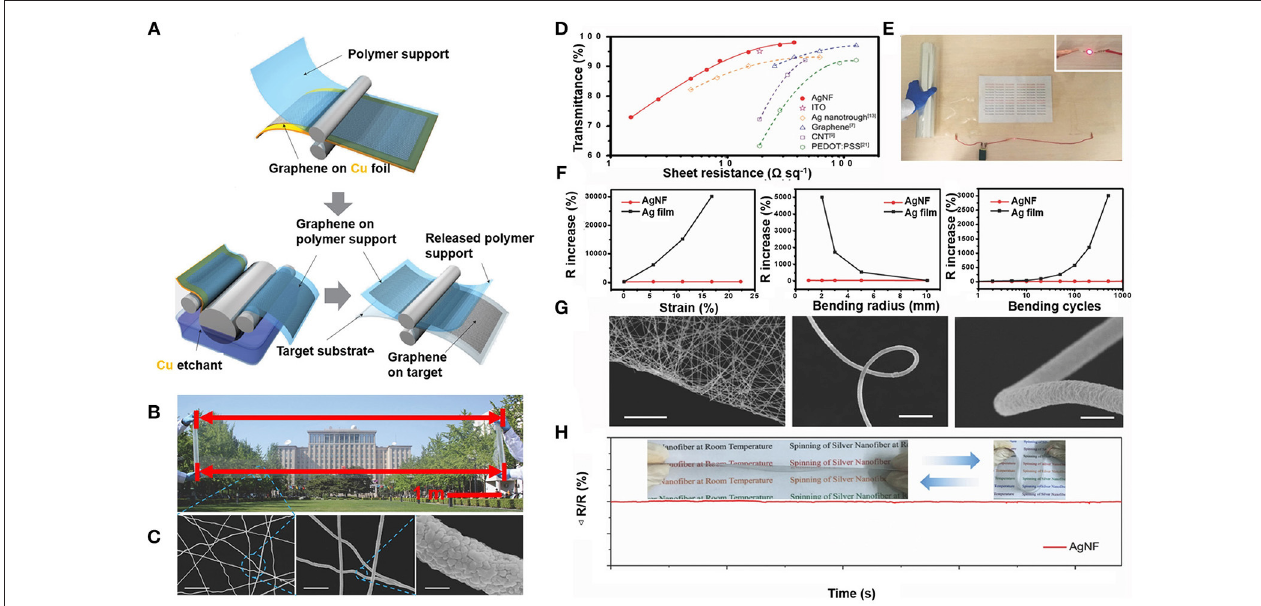
FIGURE 6 | (A) Diagram of roll-to-roll printing for screen-printing (Bae et al., 2010). Reproduced with the permission of 2010 Macmillan Publishers Limited. (B) Optical images of silver nanofiber electrodes. (C) SEM images of silver nanofibers. (D) Comparison of sheet resistivity among silver fiber electrodes and other transparent electrodes. (E) Demonstration of LED illuminance utilizing fabricated electrodes. (F) Variations in the sheet resistance of silver nanofibers and Ag on PET substrates under varying bending radii. (G) SEM images of silver nanofibers under bending. (H) The stability test of a conductive tape consisting of PET/silver nanofiber/PET (Lin S. et al., 2017). Reproduced with the permission of 2017 WILEY-VCH Verlag GmbH & Co. KGaA,